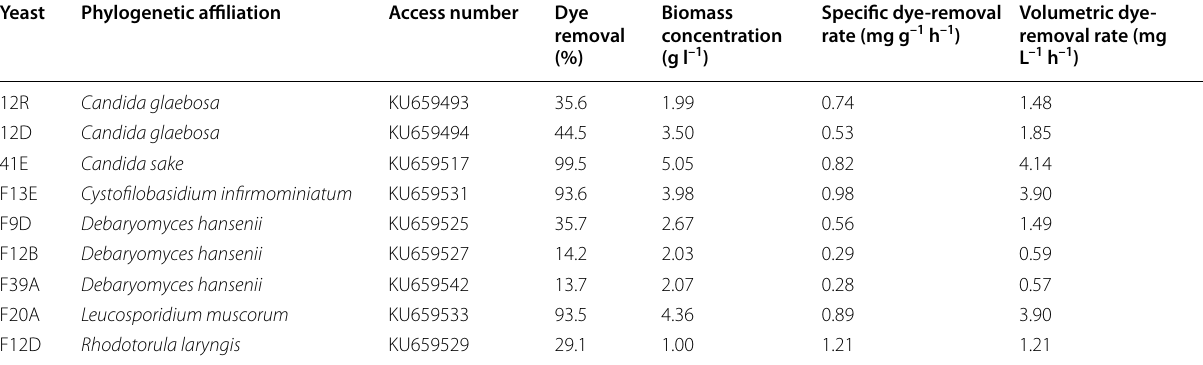
Table 3 Genus and species of the yeasts selected for the study of dye-removal kinetics and the kinetic parameters of percent color removal and biomass concentration after 24